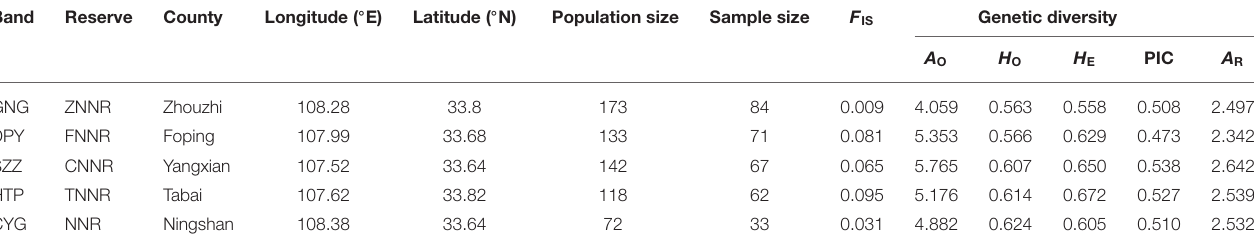
TABLE 1 | Genetic diversities of five